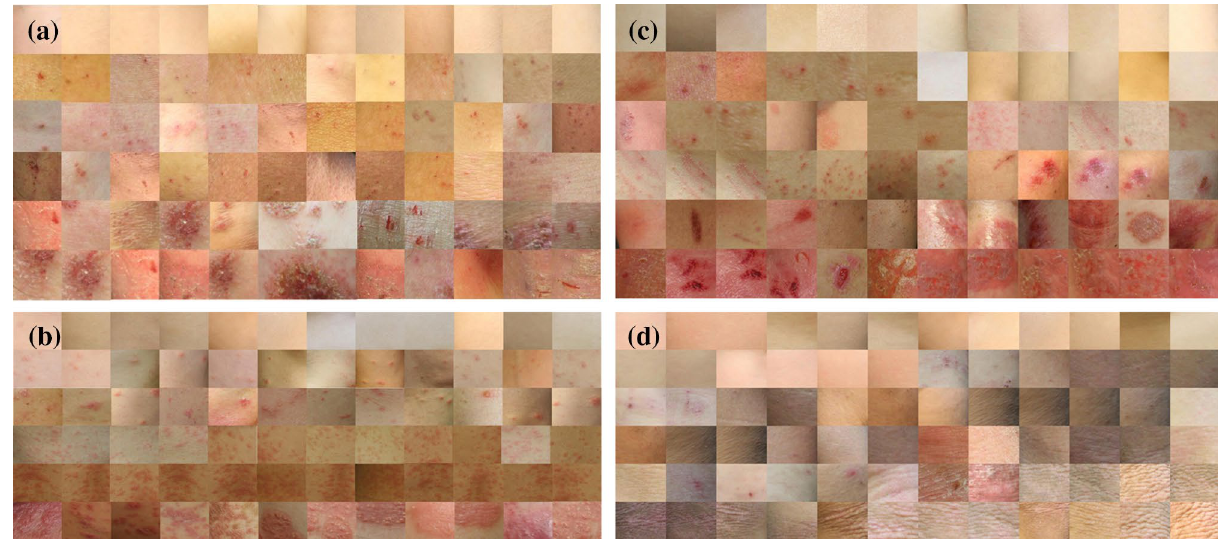
Figure 1. Examples of cropped images of the 4 components of EASI from a standard clinical dataset: ( a ) erythema, ( b ) induration/papulation, ( c ) excoriation and ( d )